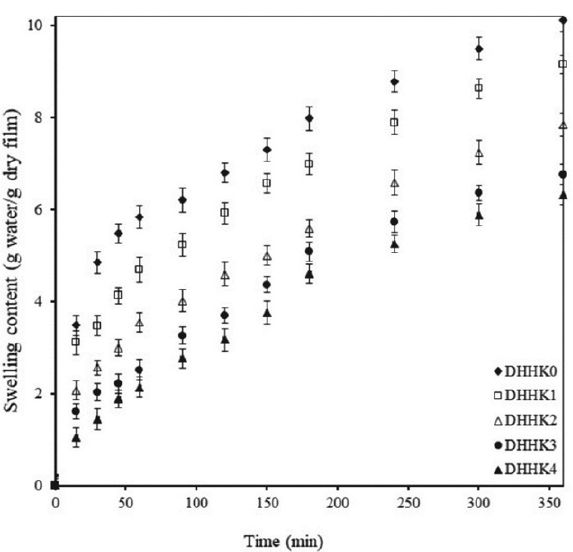
Figure 4. Swelling content of film of HPMC K100 M (H H ) matrix with varied kaolin content.